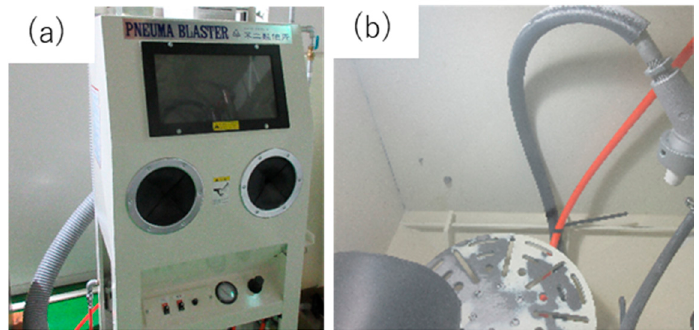
Figure 5. Mechanical blasting equipment. ( a ) Overall image of blasting equipment and ( b ) the shooting stage for blasting the substrates in manual operation.